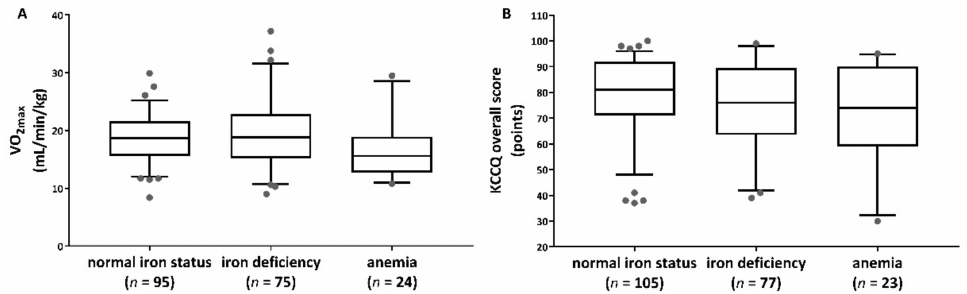
Figure 2. Group differences (normal iron status, iron deficiency, and anemia) related to relative oxygen uptake ( A ) and KCCQ overall score ( B ) by boxplots. Data that fall outside the Q1–Q3 range are shown as outliers of the